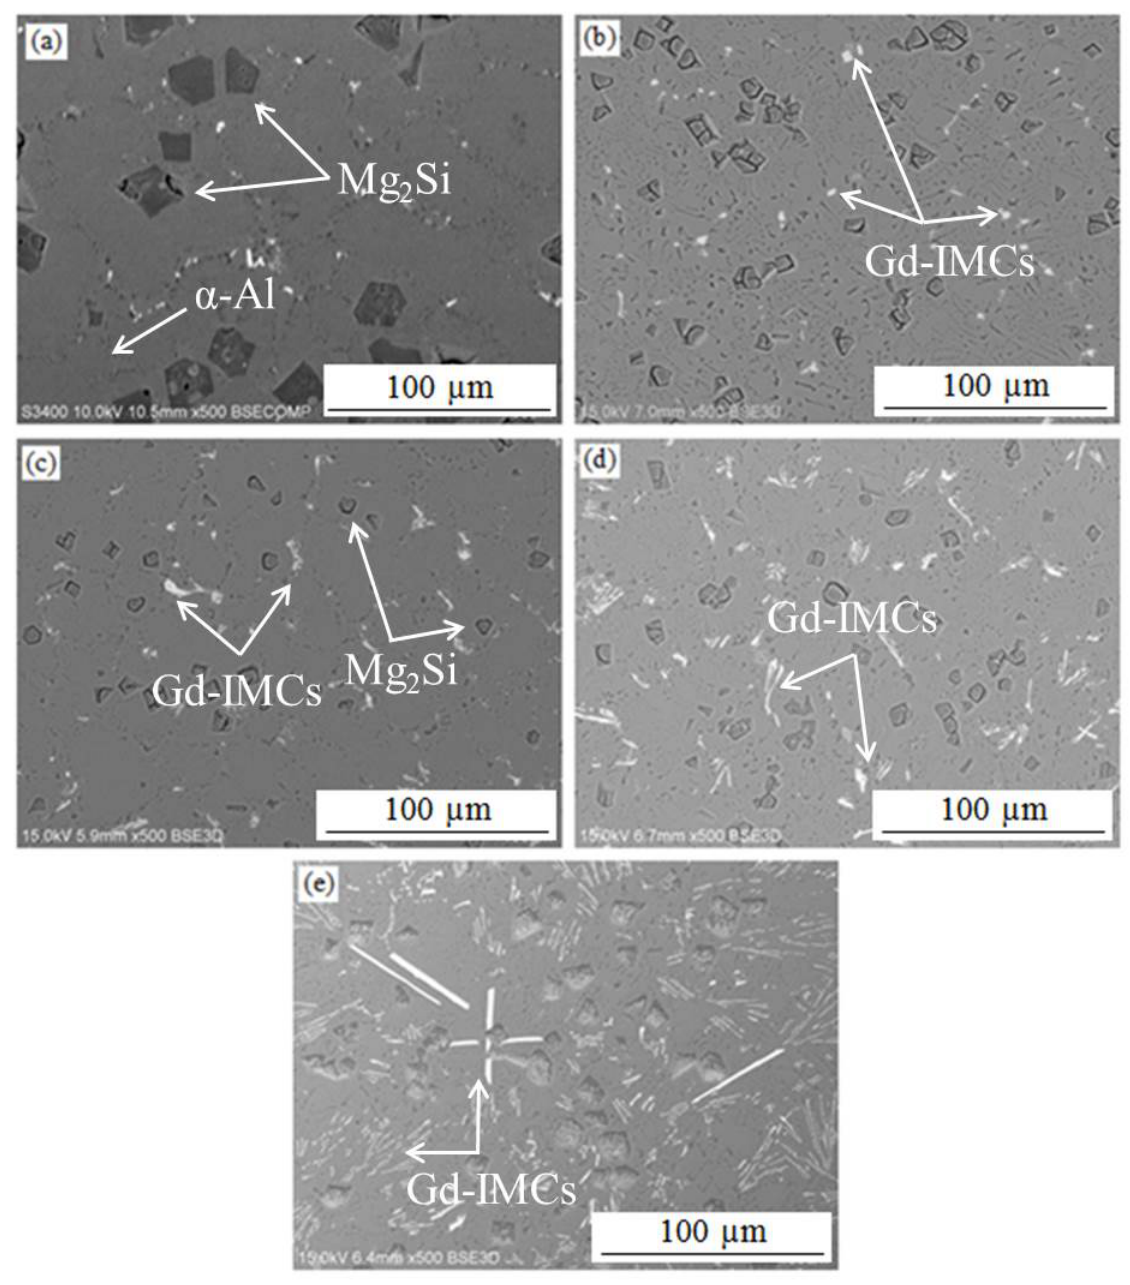
Fig. 2. SEM micrographs of Al–15% Mg 2 Si composites with different Gd concentrations: (a) 0 wt. %, (b) 0.5 wt. % (c) 1.0 wt. %, (d) 2.0wt% and (e) 5.0 wt.